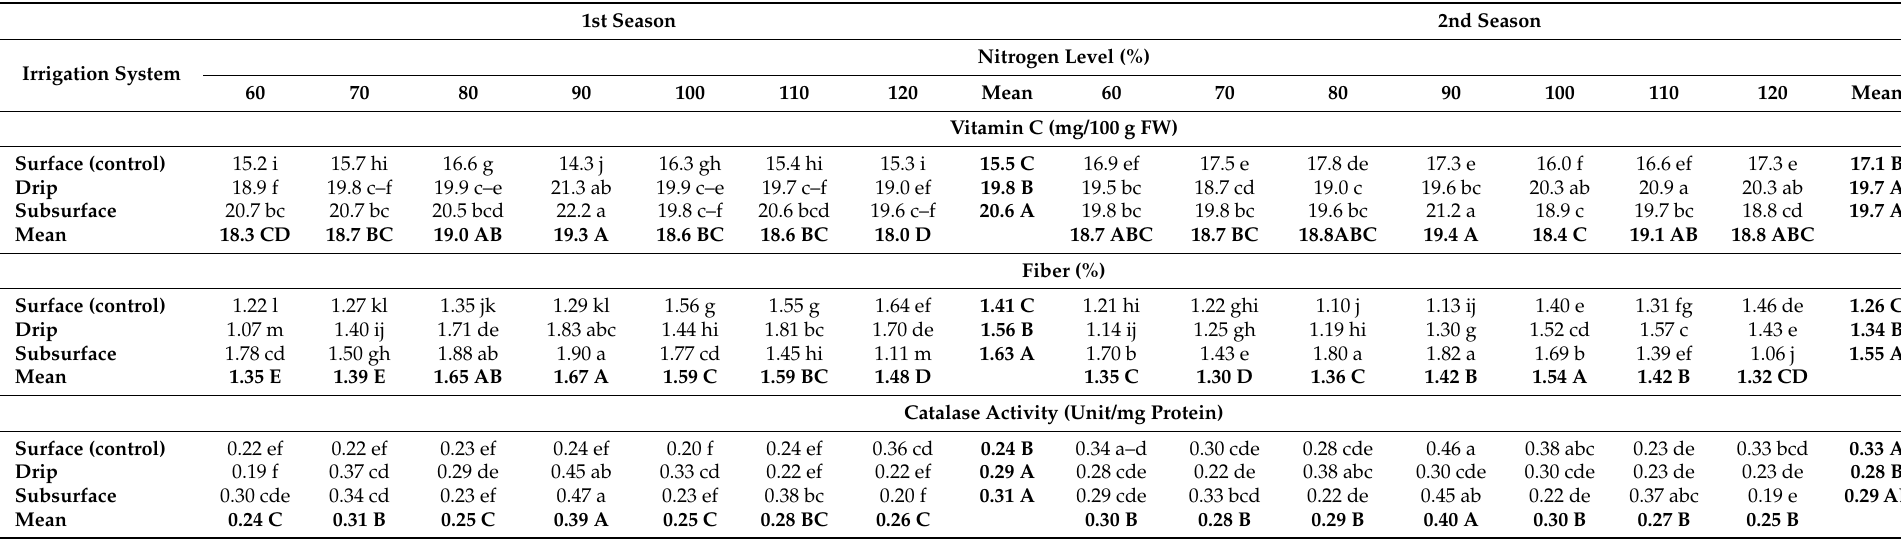
Table 5. Chemical measurements’ means at different irrigation systems and nitrogen treatments in seasons 2019 and